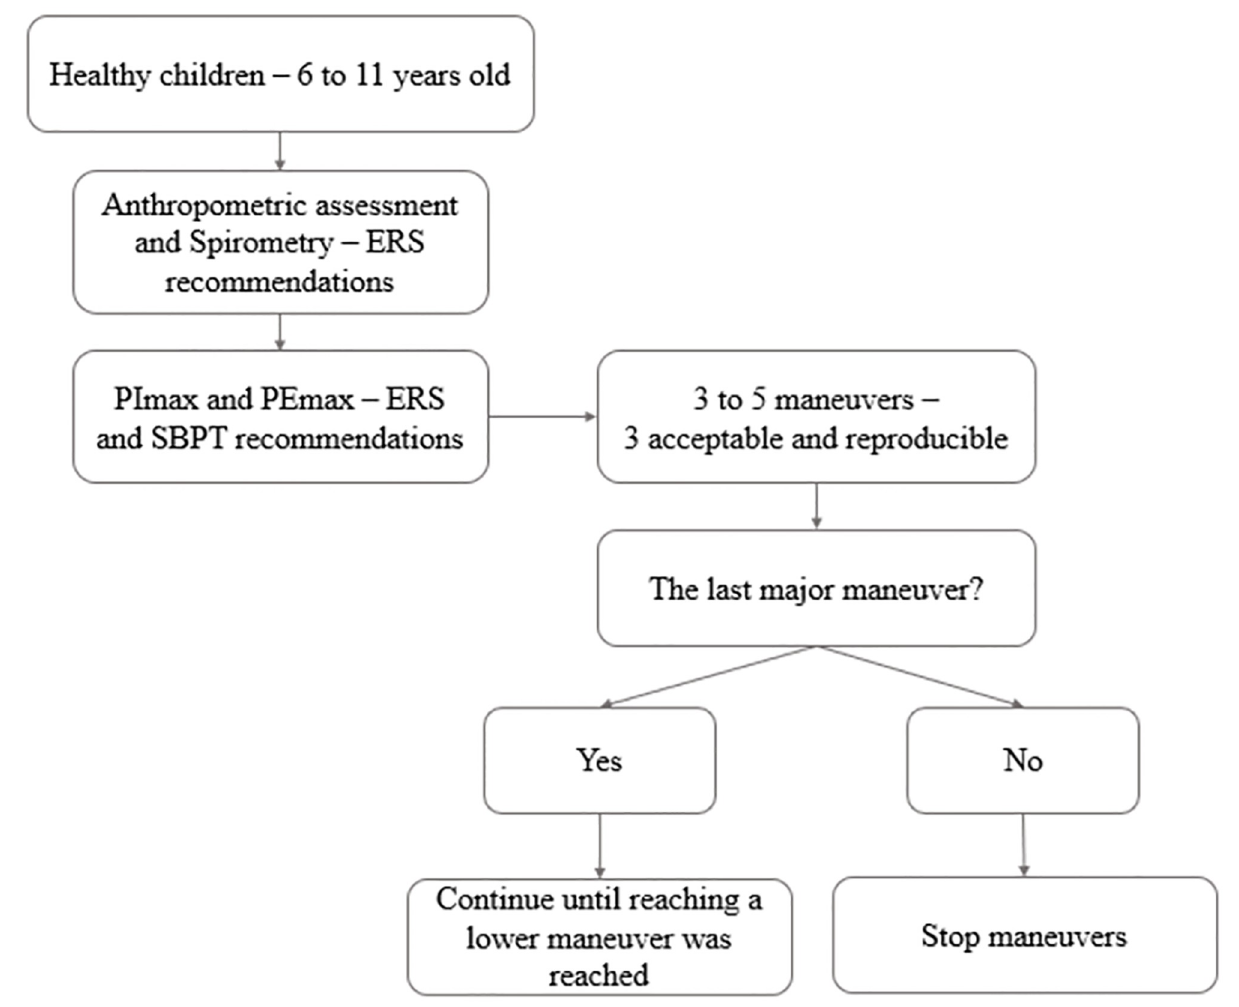
Fig 1. Study design